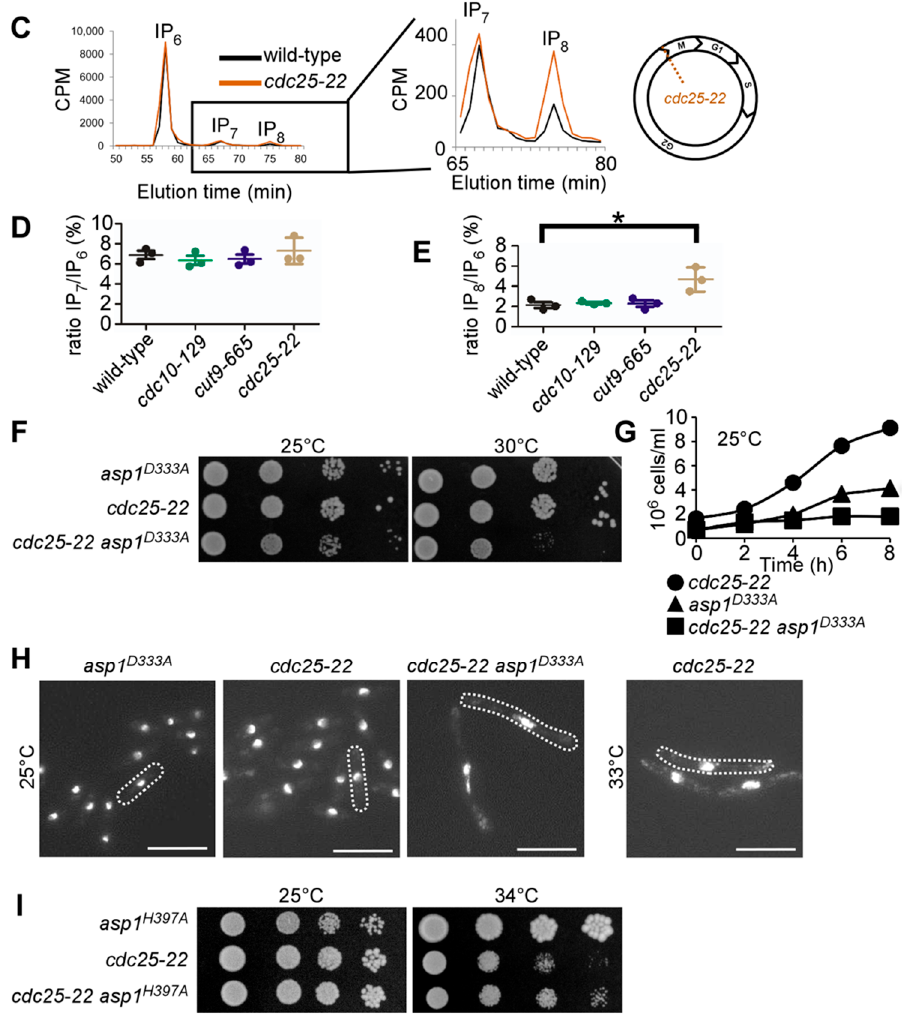
Figure 2. IP 8 is cell-cycle regulated and required for mitotic entry . ( A – C ) Typical HPLC profiles of soluble inositol phosphates and pyrophosphates extracted from cells that were arrested in ( A ) G1 ( cdc10-129) ; ( B ) metaphase-anaphase A transition ( cut9-665), and ( C ) G2/M boundary ( cdc25-22) compared to wild-type controls that were treated as the cdc strains. Boxed regions define the magnification of the IP 7 and IP 8 peaks shown on the right side. A schematic representation indicating where in the cell-cycle the indicated mutant arrests is shown in the right most panels. Wild-type and temperature-sensitive cdc strains were labeled with [ 3 H] inositol and pre-grown at 25 ◦ C before a shift to 36 ◦ C for 6 h prior to the soluble inositol extraction. Counts per minute (CPM). ( D ) Quantification of the IP 7 levels relative to IP 6 . Wild-type = 6.88 ± 0.72; cdc10-129 = 6.35 ± 0.79; cut9-665 = 6.48 ± 0.78; cut25-22 = 7.29 ± 1.31 ( E ) Quantification of the IP 8 levels relative to IP 6 . Wild-type = 2.12 ± 0.5; cdc10-129 = 2.34 ± 0.14; cut9-665 = 2.26 ± 0.57; cdc25-22 : 4.68 ± 1.18. For ( D , E ), the mean and SD of n = 3 are shown. *, p = 0.0258 using a t -test. ( F ) Serial dilution patch test (10 4 –10 1 cells) of indicated strains were grown for 3 (30 ◦ C) or 4 days (25 ◦ C) on YE5S plates. ( G ) Growth rates of the indicated strains grown in liquid YE5S at 25 ◦ C. ( H ) Photomicrographs of fixed cells that were stained with DAPI to reveal the nucleus. Dotted lines indicate the cell periphery. Scale bars, 10 µ m. ( I ) Serial dilution patch test (10 4 –10 1 cells) of indicated strains grown for 4 days at the indicated temperatures on YE5S